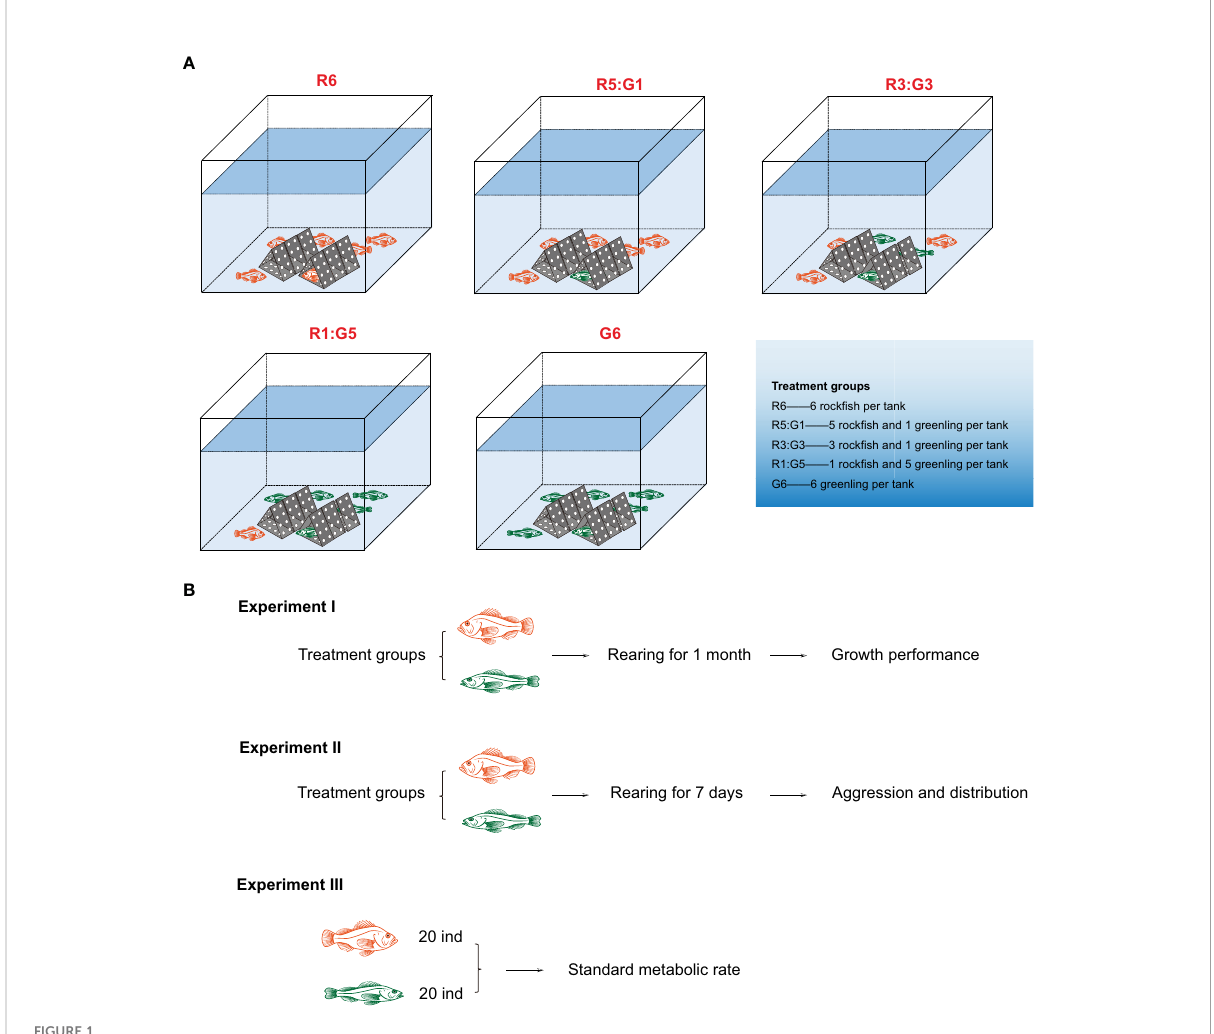
FIGURE 1 Sketches of (A) treatment groups and (B) overall experimental setup of this